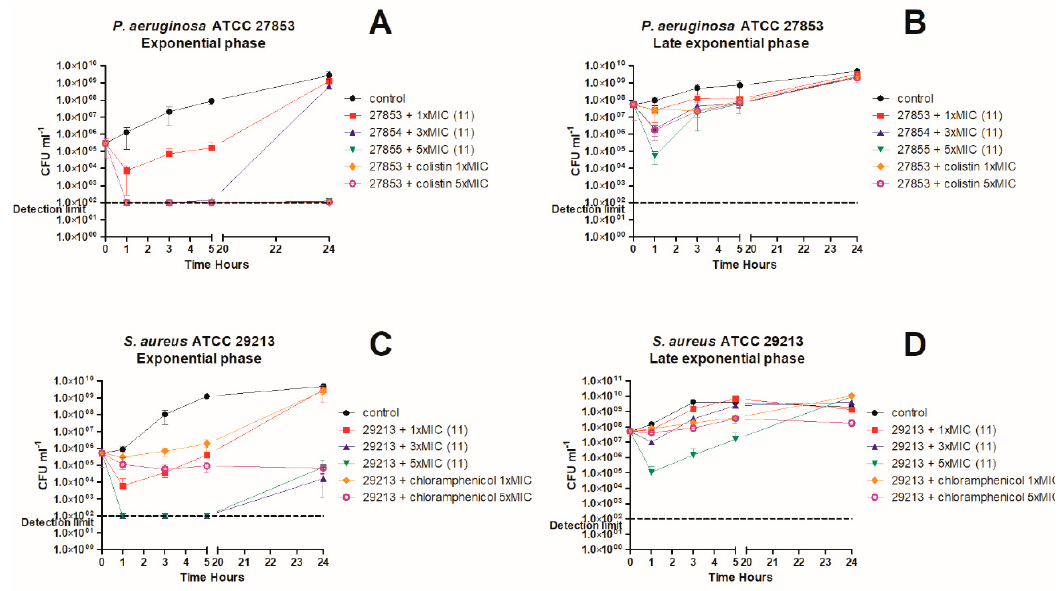
Figure 1. Time-Kill Curves. Bactericidal activities of 11 and colistin at di ff erent concentrations against P. aeruginosa in the exponential phase ( A ) and late exponential phase ( B ), and chloramphenicol at di ff erent concentrations against S. aureus in the exponential phase ( C ) and late exponential phase ( D ).